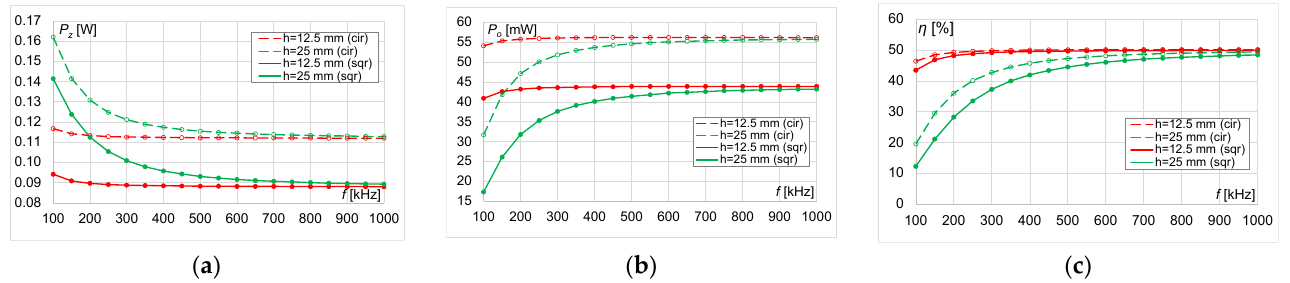
Figure 26. Results for circular and square coils with r = 25 mm and number of turns n = 70 at different distances ( h = 12.5 mm and h = 25 mm): ( a ) transmitter power, ( b ) receiver power and ( c ) power transfer efficiency.